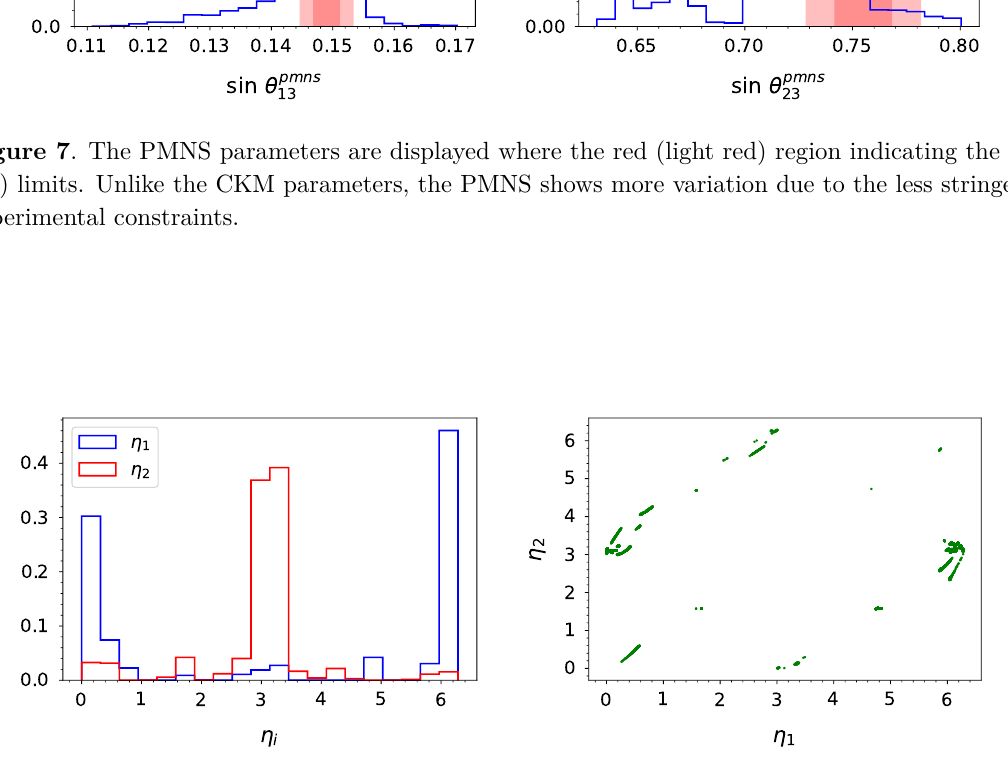
Figure 8 . A representation of the Majorana phases is presented. The first panel shows the density of values for the two phases while the second shows their strong